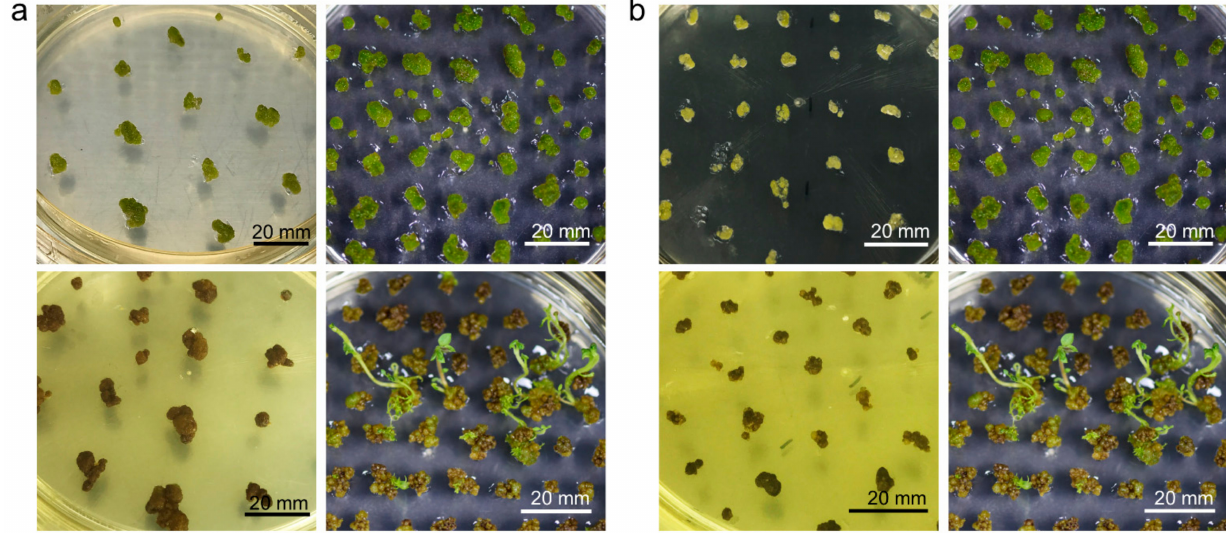
Figure 6. ( a ) Comparison of shoot regeneration from green calli in two different types of media. The upper panels show green calli over 5 mm in size in SI1 medium (left panel) and SI2 medium (right panel). The lower panels show the same calli as those in the upper panels after 1 month. ( b ) Comparison of shoot regeneration from green calli of different sizes in SI2 medium. The upper panels show green calli 2–5 mm in size (left panel) and over 5 mm in size (right panel). The lower panels show the same calli as those in the upper panels after 1 month.